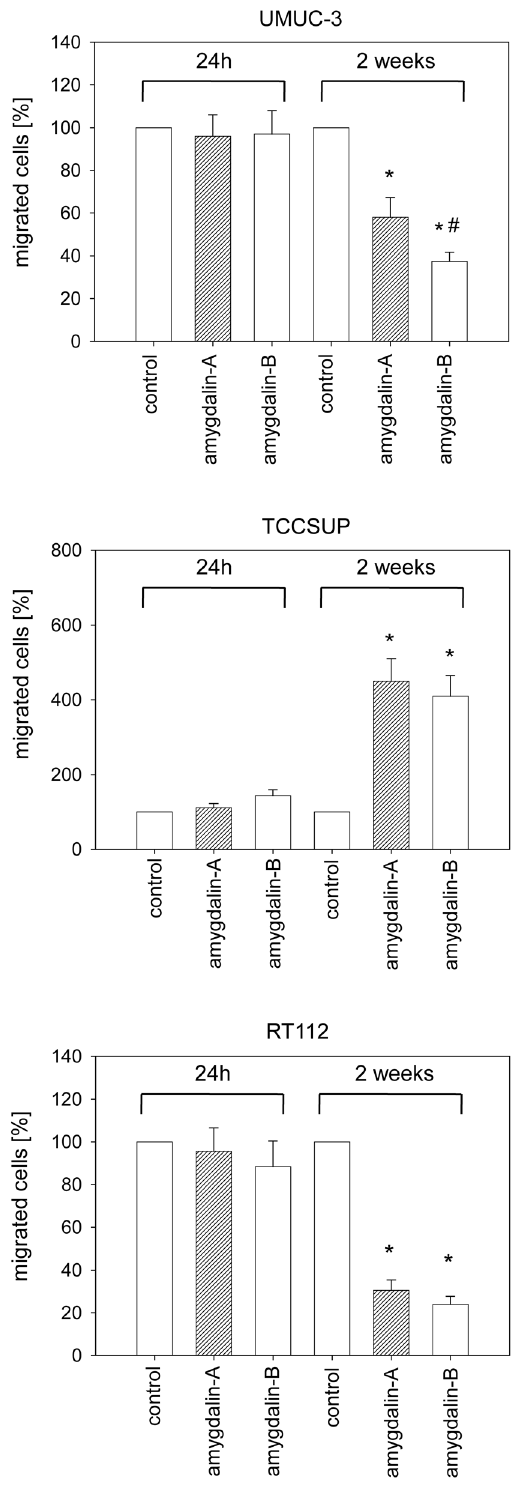
Figure 3. Effect of amygdalin on bladder cancer cell migration. Tumor cells treated with amygdalin for 24 h or for 2 weeks were seeded in the upper chamber with a chemo-attractant in the lower well. Cells were allowed to move for 20 h, either in amygdalin-free medium (amygdalin-A) or in amygdalin-containing medium (amygdalin-B). Cells migrating to the lower membrane surface were counted. Controls were set to 100%. One representative of six experiments is shown. *